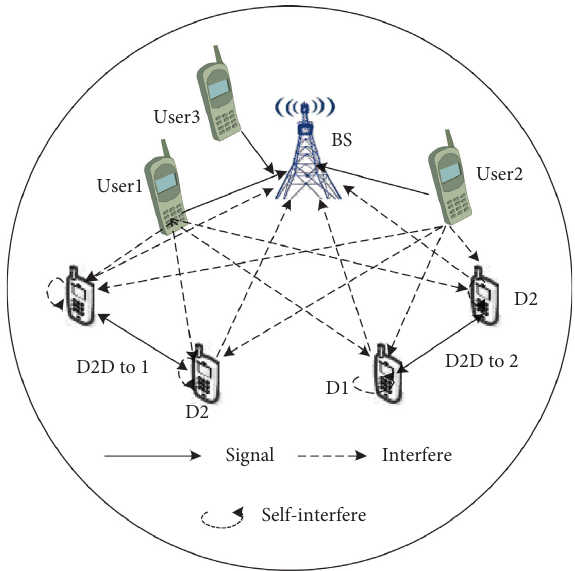
Figure 1: Cellular network